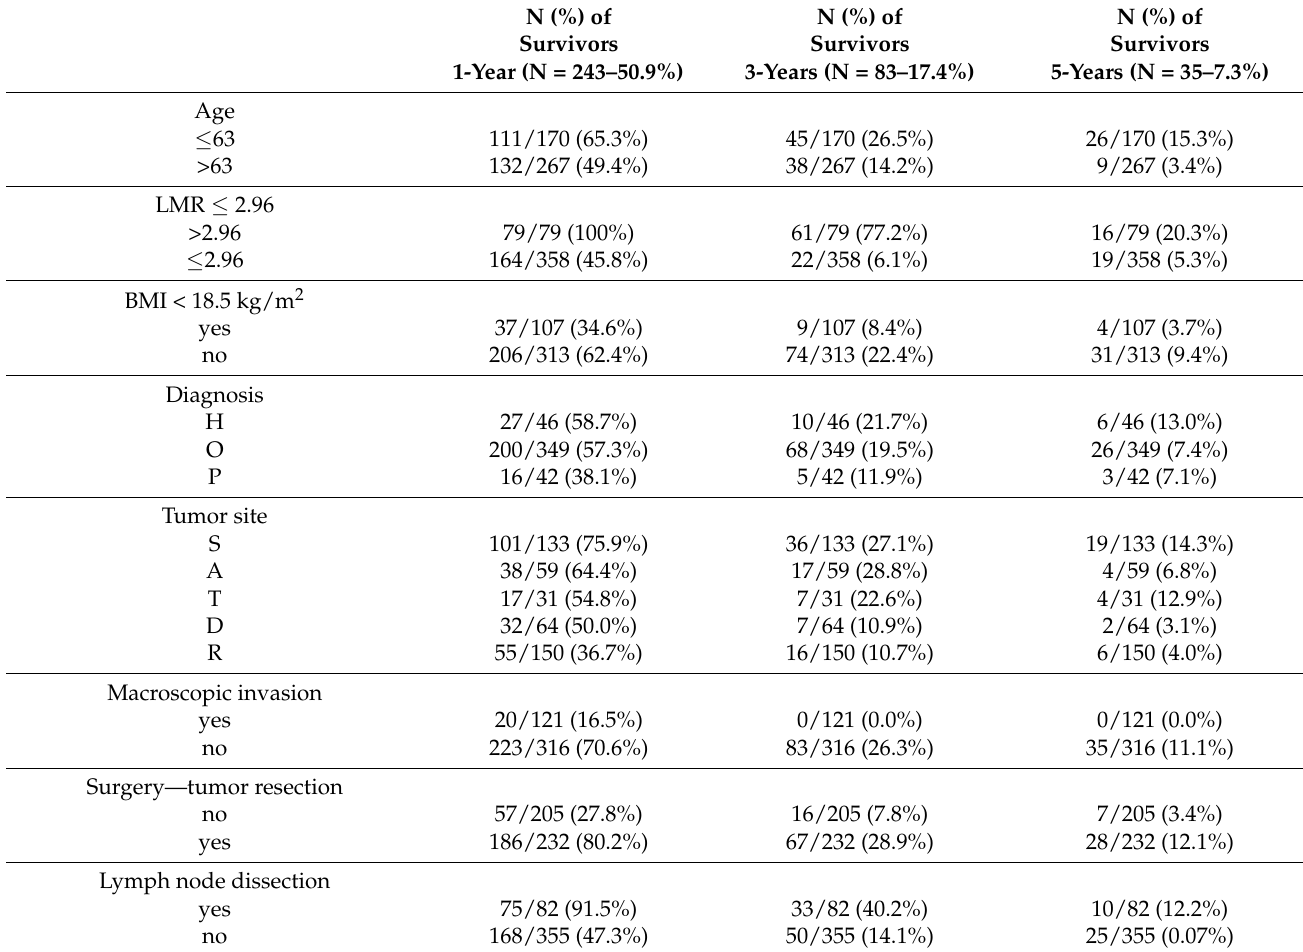
Table 2. The 1-year, 3-year, and 5-year overall survival in terms of patient characteristics. N (%)